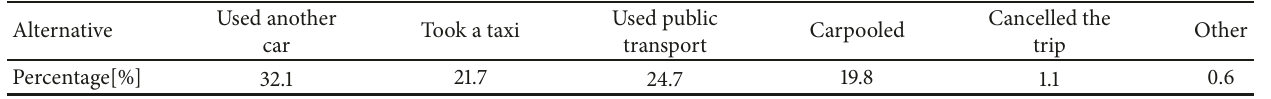
Table 6: Reaction of members when car-sharing was not available.